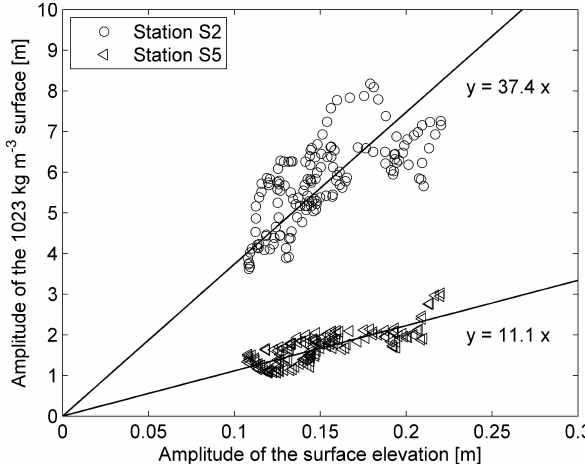
Fig. 9. The amplitude of the displacement of the 1023kgm − 3 den- sity surface at station S2 (circles) and S5 (triangles) plotted as a function of the amplitude of the surface elevation. The lines are least square fits intercepting the